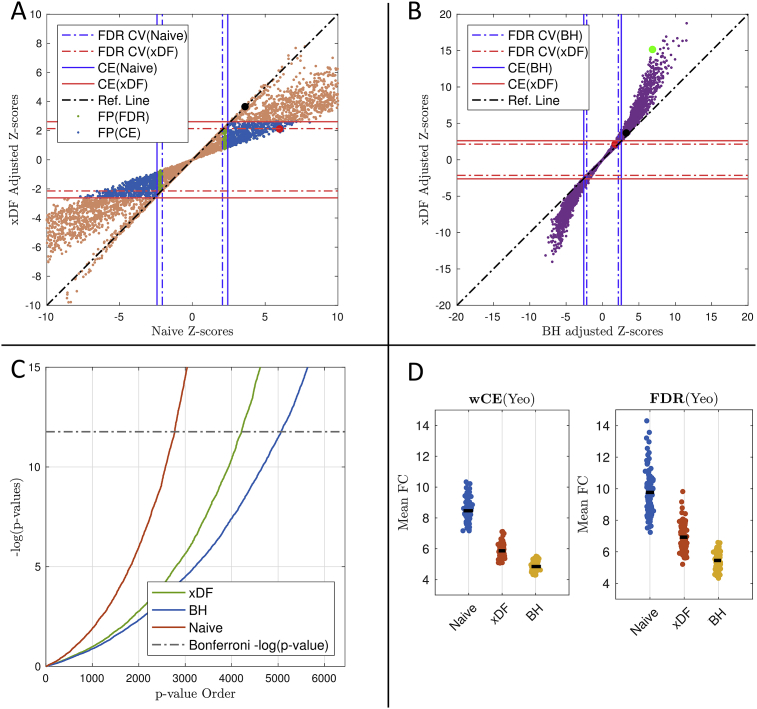
Impact of Naive, xDF and BH corrections on rsFC in one HCP subject parcellated with the Yeo atlas. Panel A plots rsFC Z-scores of xDF-corrected connectivity vs. Naive, showing that the significance of edges with Naive computation of V(ρˆ) is almost always inflated, but to varying degrees. Solid lines are the critical values corresponding to the cost-efficient (CE) density. Dashed lines illustrates the critical values of FDR-corrected q-values. Taking xDF as reference, edges that are incorrectly detected with Naive are coloured green (FDR but not CE) and blue (CE). The black point marks edge (37,94) and red point (13,25), discussed in body text. Panel B plots rsFC Z-scores of xDF-corrected connectivity vs. BH, same conventions as Panel A, showing deflated significance of Z-scores computed with the BH method. The green point marks edge (103,104). Panel C pp-plot of p-values of Z-scores from xDF (green), BH (blue) and Naive (red) corrections. Dashed line is %5 Bonferroni threshold for 6441 edges. Panel D shows the differences in mean functional connectivity (mFC) of each correction method across statistical (FDR) and proportional (CE) thresholding. See Fig. S10 for a similar plot for a different HCP Subject.